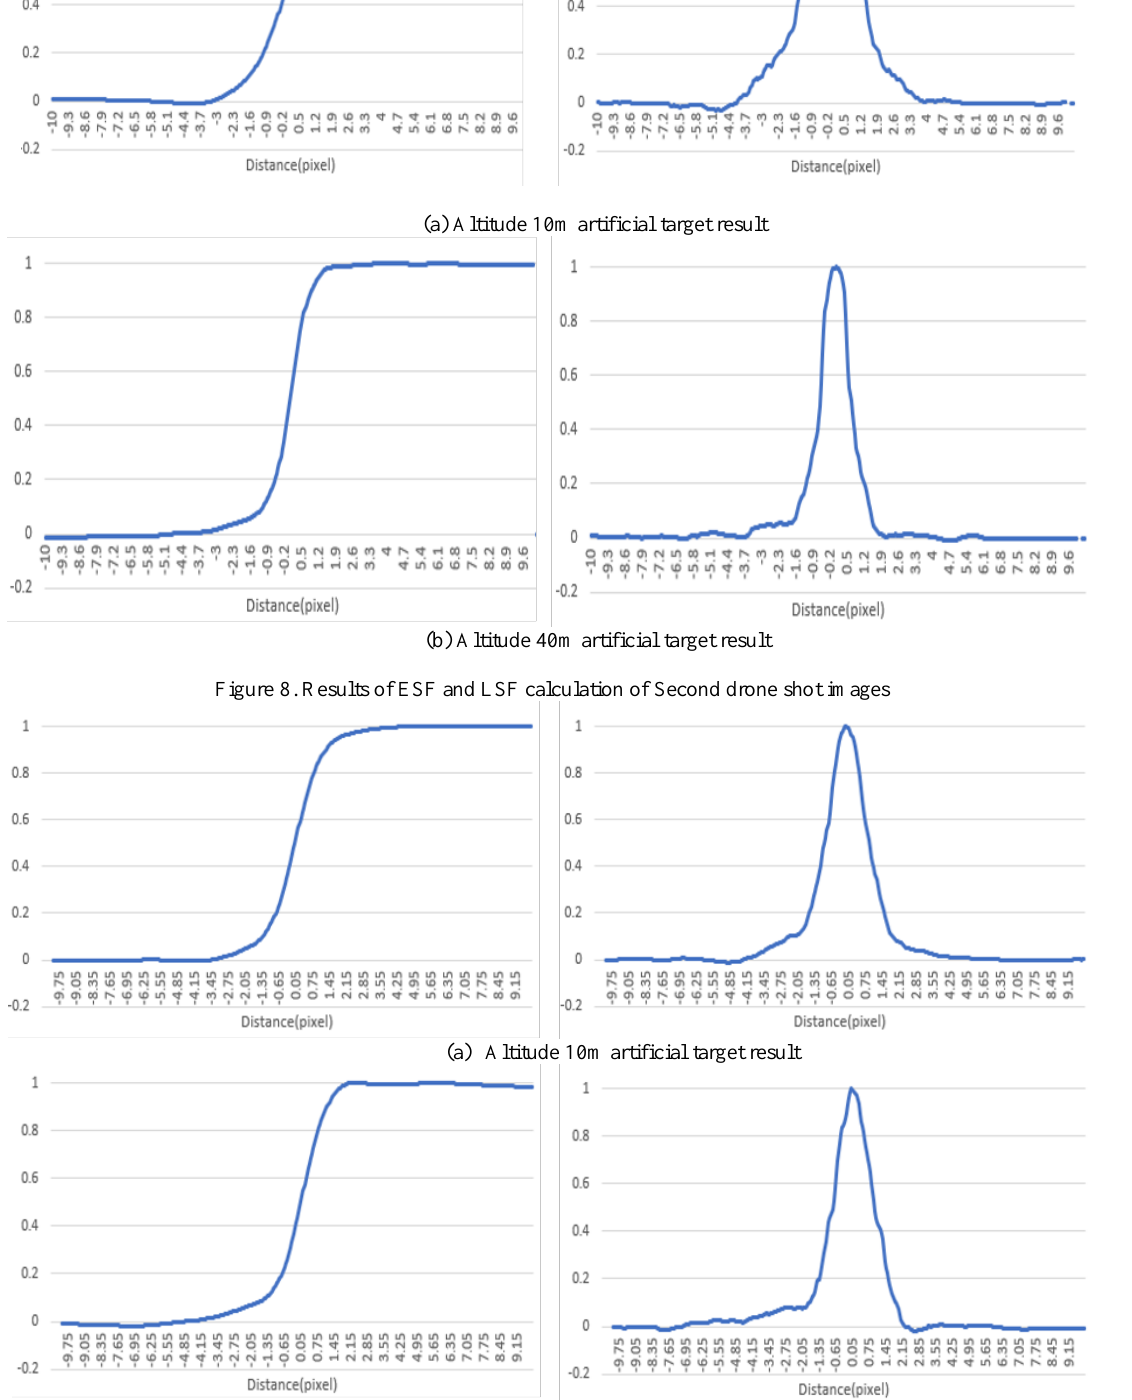
Figure 9. Results of ESF and LSF calculation of Third drone shot